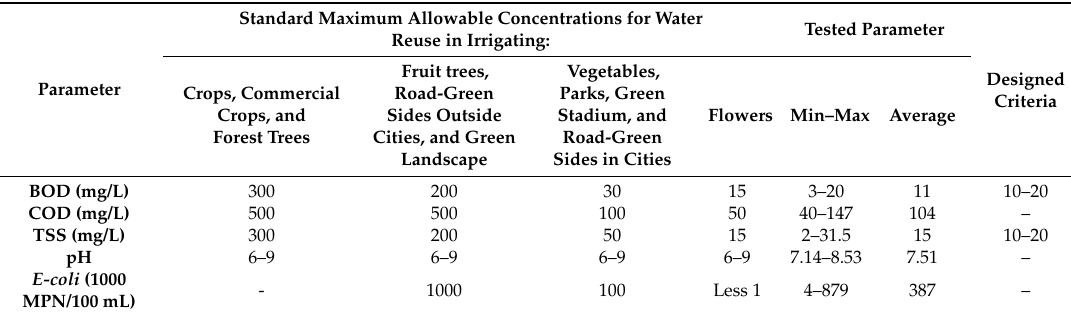
Table 1. Testing results in accordance with the Jordanian